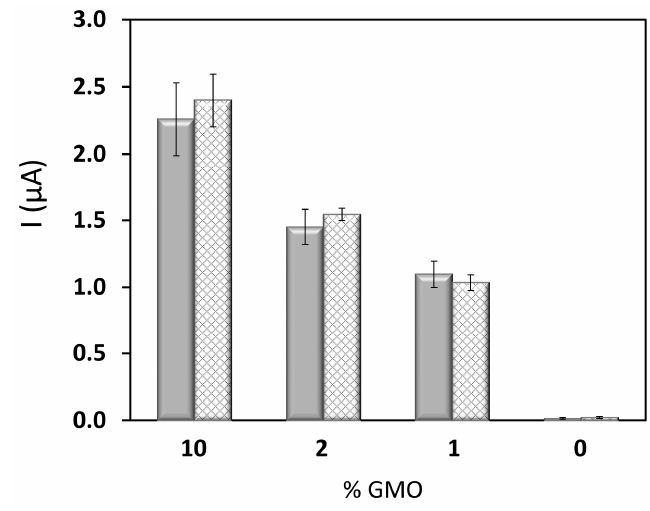
Figure 4. Variation of the chronoamperometric signal, in absolute value, recorded using the PCR-electrochemical genosensor method with GMO percentage. MON810 maize (solid grey), GTS40-3-2 (striped grey).